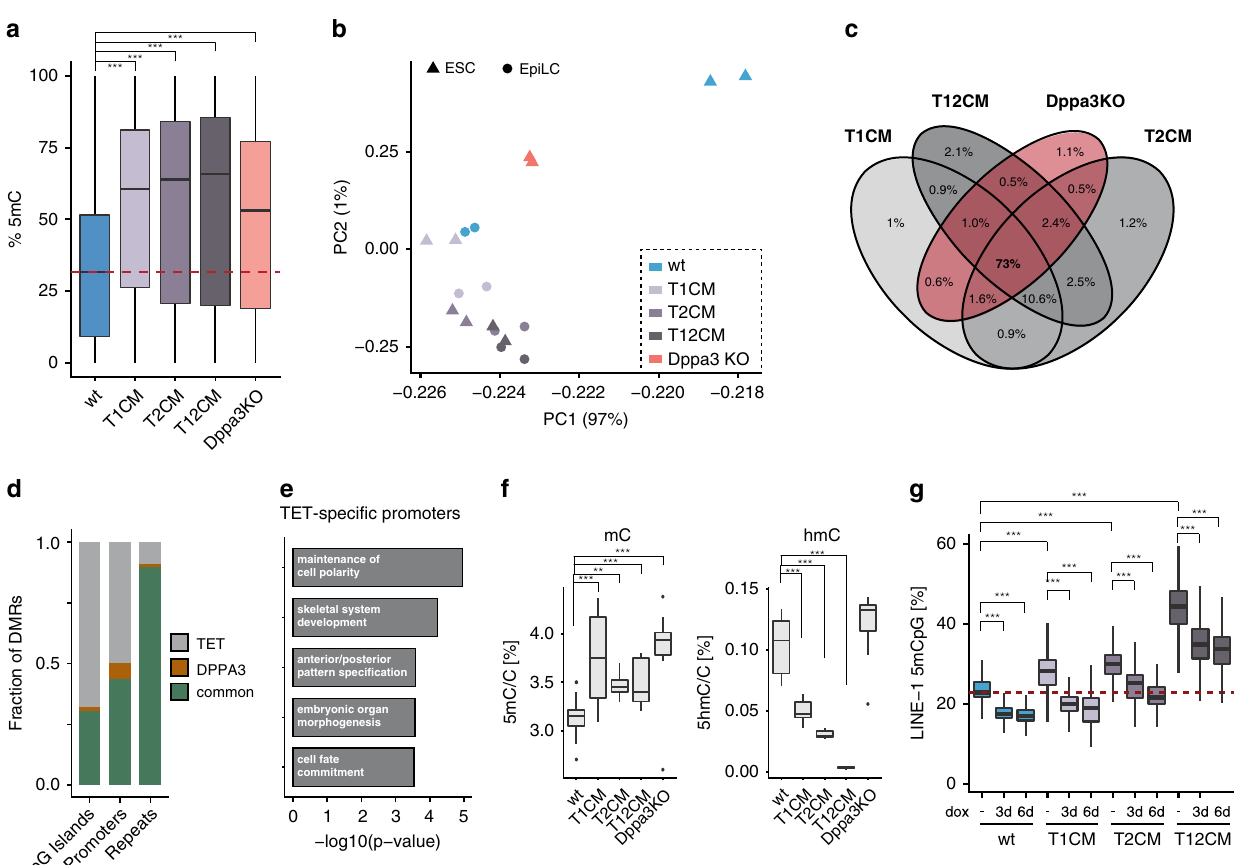
Fig. 3 DPPA3 acts downstream of TET1 and TET2 to establish and preserve global hypomethylation. a Dppa3 loss results in global hypermethylation. Percentage of total 5mC as measured by RRBS using n = 2 biologically independent samples per condition. b Dppa3 prevents the premature acquisition of a primed methylome. Principal component (PC) analysis of RRBS data from wt, T1CM, T2CM, and T12CM ESCs and EpiLCs and Dppa3KO ESCs. c DPPA3 and TET proteins promote demethylation of largely similar targets. Venn Diagram depicting the overlap of hypermethylated sites among T1CM, T2CM, T12CM, and Dppa3KO ESCs. d Dppa3 protects mostly repeats from hypermethylation. Fraction of hypermethylated genomic elements classi fi ed as TET- speci fi c (only hypermethylated in TET mutant ESCs), DPPA3-speci fi c (only hypermethylated in Dppa3KO ESCs), or common (hypermethylated in TET mutant and Dppa3KO ESCs). e Gene ontology (GO) terms associated with promoters speci fi cally dependent on TET activity; adjusted p-values calculated using a two-sided Fisher ’ s exact test followed by Benjamini-Hochberg correction for multiple testing. f TET activity remains unaffected in Dppa3KO ESCs. DNA modi fi cation levels for 5-methylcytosine (5mC) and 5-hydroxymethylcytosine (5hmC) as measured by mass spectrometry (LC-MS/MS) in wt ( n = 24), T1CM ( n = 8), T2CM ( n = 12), T12CM ( n = 11), Dppa3KO ( n = 12) mESC biological replicates. g Dppa3 expression can rescue the hypermethylation in TET mutant ESCs. DNA methylation levels at LINE-1 elements (%) as measured by bisul fi te sequencing 0, 3, or 6 days after doxycycline (dox) induction of Dppa3 expression using n = 2 replicates per condition. The dashed red line indicates the median methylation level of wt ESCs. In the boxplots in ( a , f and g ), horizontal black lines within boxes represent median values, boxes indicate the upper and lower quartiles, and whiskers extend to the most extreme value within 1.5 x the interquartile range from each hinge. In ( a , f , and g ), p -values were calculated using Welch ’ s two-sided t -test: *** p < 2e − 16. Source data are provided as a Source Data fi